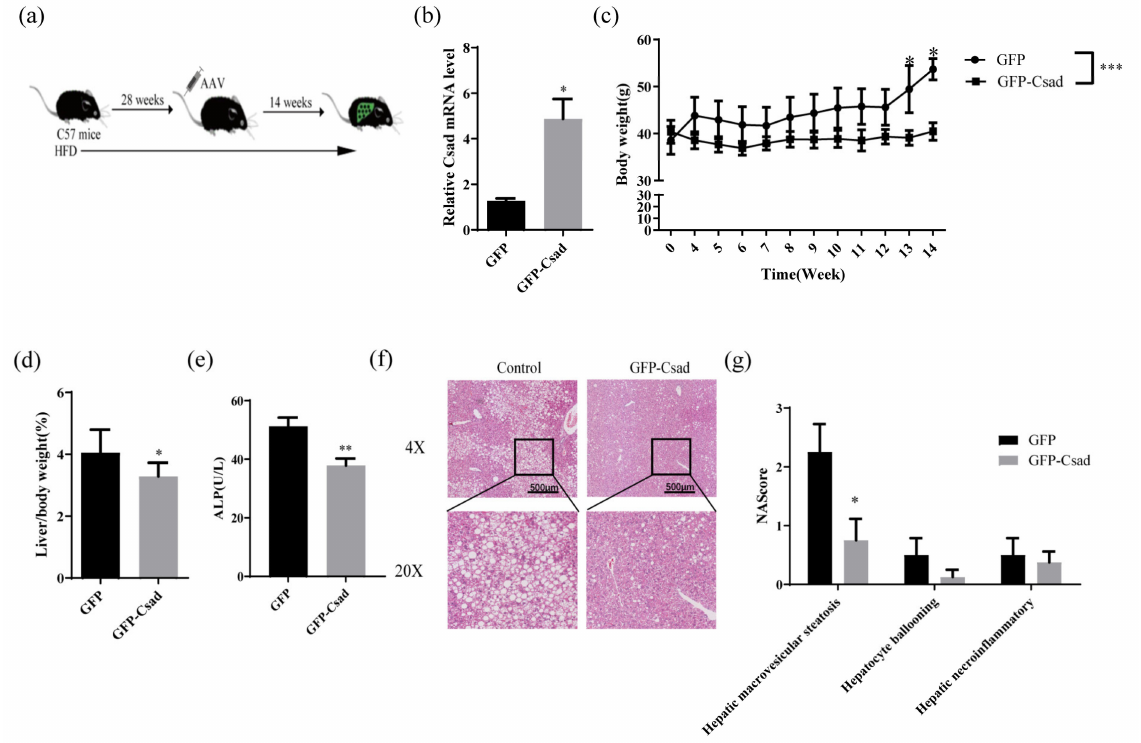
Figure 2. Overexpression of CSAD-inhibited weight gain and liver injury induced by an HFD. ( a ) The schematic diagram of animal experiments. ( b ) The expression of CSAD in the liver. ( c ) The body weight of mice during the whole experiment. Two-way ANOVA was used to analyze the data. *** p < 0.001 ( d ) The ratio of liver weight to body weight. ( e ) The content of ALP in serum. ( f ) Representative images of H&E staining of liver tissues. ( g ) The histological scores of macrovesicular steatosis, ballooning, and necroinflammatory activity for ( f ). The pathologist, who was blinded to the experimental protocol, assessed semi-quantitatively according to the NAFLD activity scoring (NAS) system. Fourteen weeks post-injection of AAV, mice were sacrificed, and the CSAD in the liver was detected by RT-qPCR, the content of ALP in serum was detected by the automatic biochemistry analyzer, and a portion of liver tissue was fixed and then stained by hematoxylin and eosin; n = 4 in GFP group, n = 8 in Csad group; * p < 0.05, ** p < 0.01vs. GFP